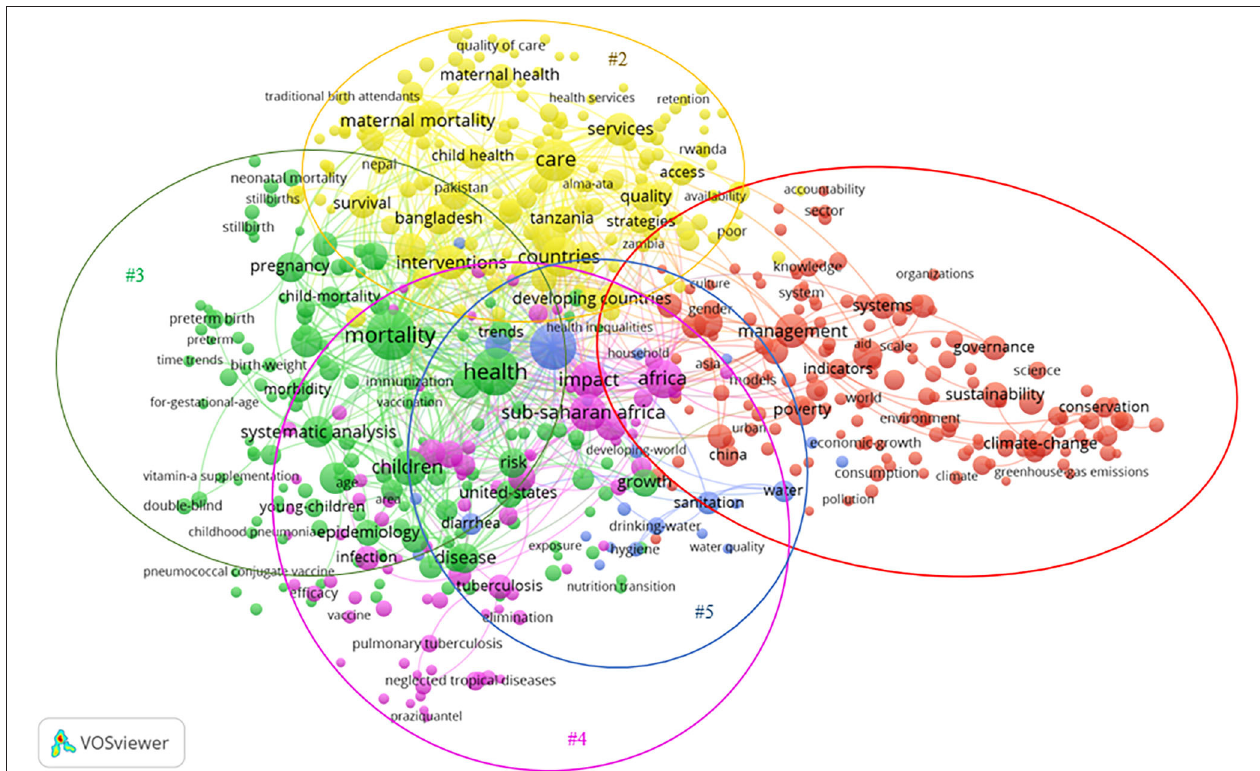
FIGURE 5 | Co-occurrence map (frequency of, at least, 50 keywords) of scientific